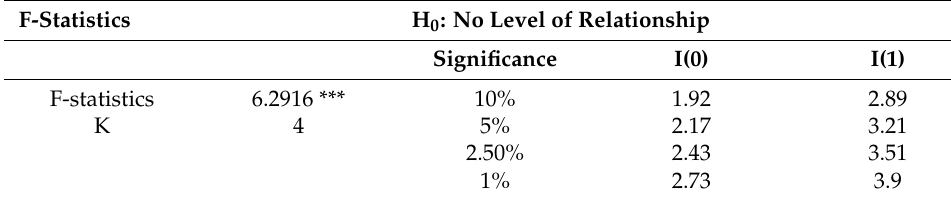
Table 10. NARDL bounds test.